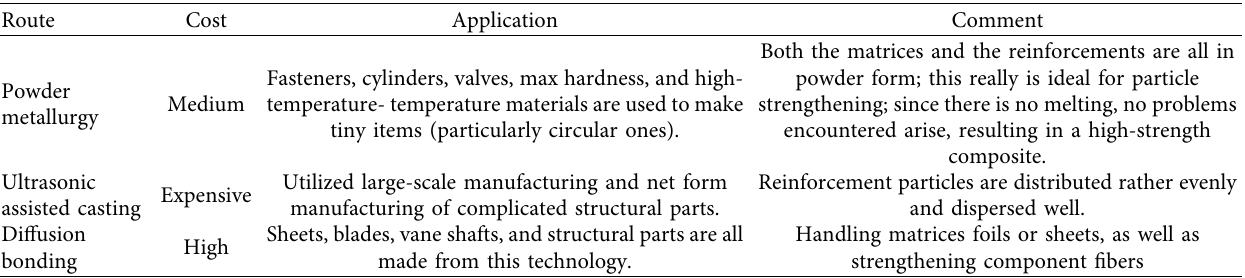
Table 8: Comparison of MMC solid-state manufacturing methods